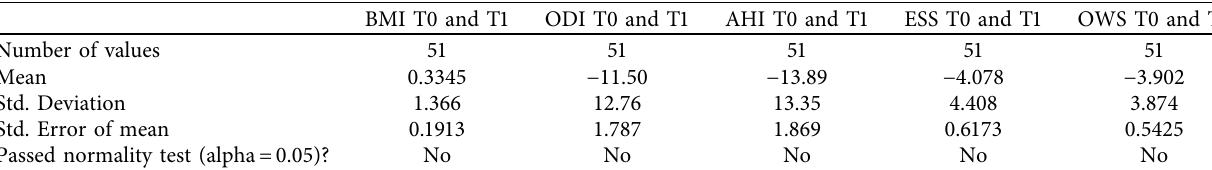
Figure 1: OSA wellness scale (OWS). Table 2: The mean difference of each evaluated